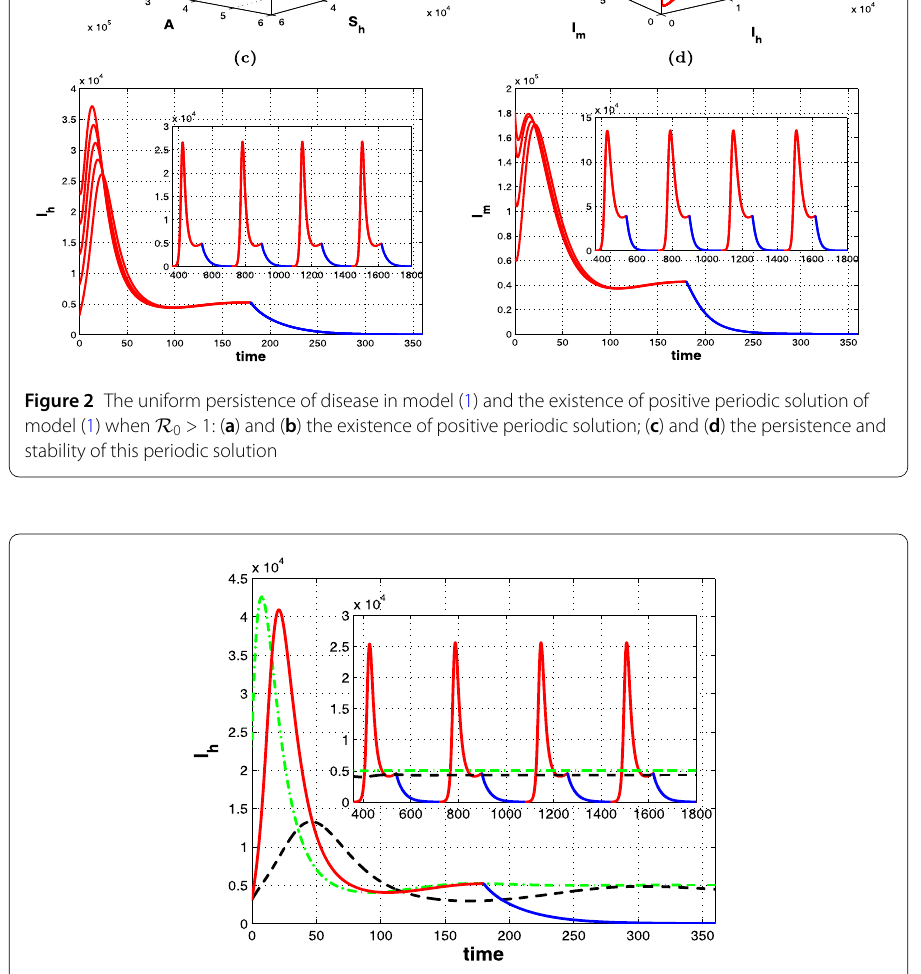
Finally, in order to investigate the effect of seasonal succession on the persistence of mosquito-borne disease, we take the autonomous model parameters β = 8.25 × 10 –7 , α = 1.23 × 10 –6 , i.e., there is no seasonal succession. By calculating, we obtain the ba- (cid:28) R ≈ 2.2784, which is close to the basic reproduction number sic reproduction number 0 R ≈ 2.2678 > 1 in Fig. 2, where the seasonal succession is considered. This is shown in 0 the black dotted line and the red-blue solid line in Fig. 3. It is not hard to find that the black dotted line undergoes a little bit of growth and then gradually goes to one value, while